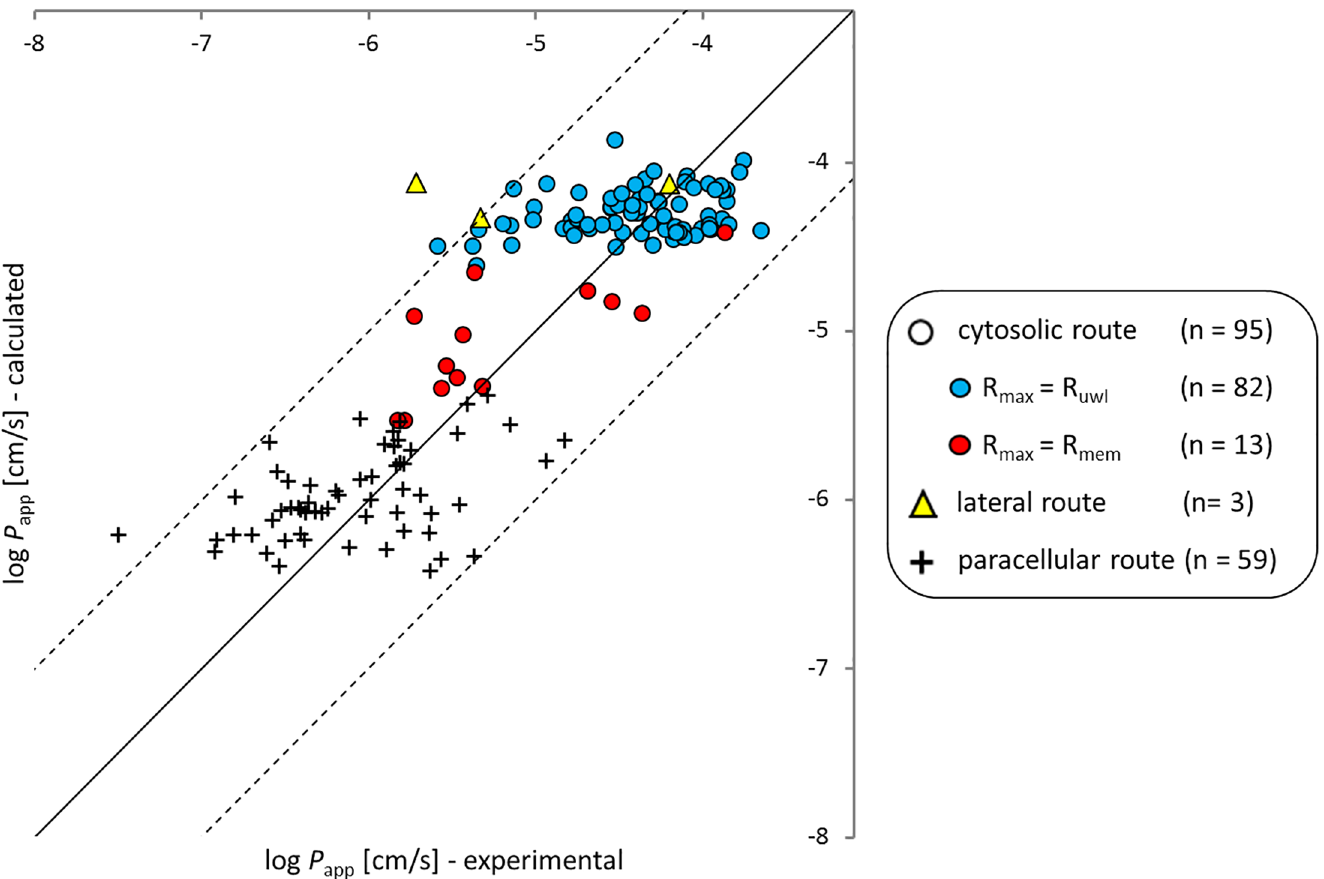
Fig 4. Experimental apparent Caco-2 and MDCK cell permeabilities (pH 7.4) vs calculated values, differentiated according to the most permeable route (i.e., the route with the lowest resistance). The symbol form is accordingto the permeation route which has the highestpermeability as shown in the legend(a circle for the cytosolic route, a trianglefor the lateral route, and a plus for the paracellularroute. For the 95 chemicalswhich permeate the cell monolayerpredominantly via the cytosolic route, the main resistancewithin the cytosolic route is color-codedas follows: for the blue circles the UWL is the main resistance,while for red circles the sum of the two membranes (apical plus basolateral)is the main resistance. Quercetin has been removedas discussedabove.